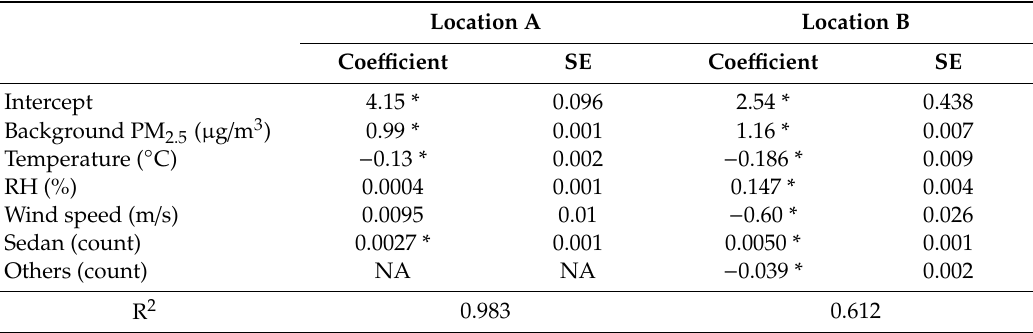
Table 3. Incremental PM 2.5 contributions ( µ g / m 3 ) of various factors from multiple regression analysis at two roadside